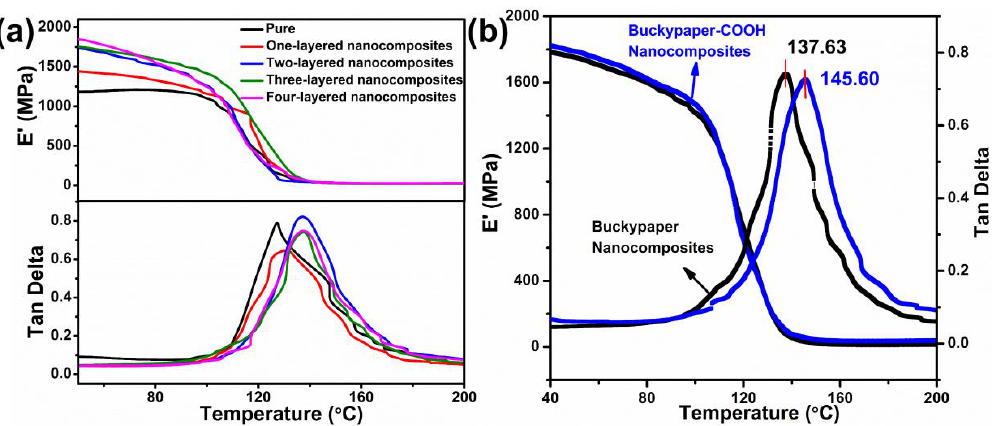
Figure 10. Temperature-dependent dynamic – mechanical data of the investigated samples. ( a ) Storage modulus plots and tan d plots of different CMC/buckypaper layers nanocomposites; ( b ) storage modulus plots and tan d plots of unmodified and modified three-layered CMC/buckypaper nanocomposites.